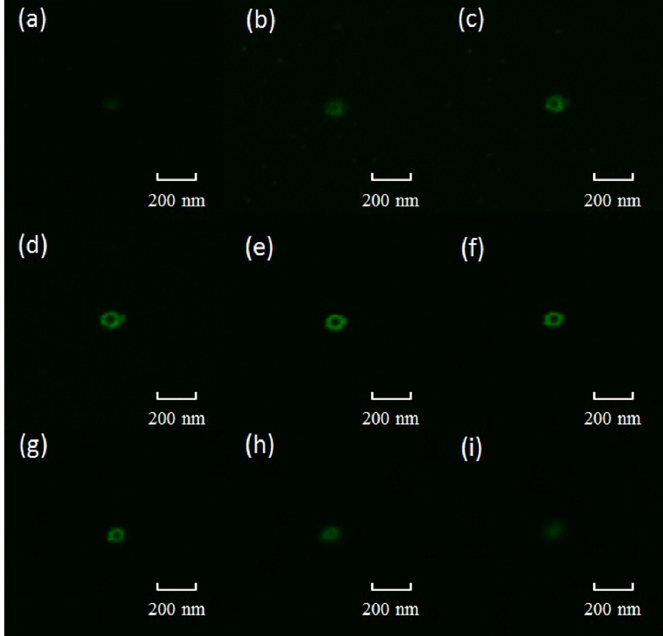
Figure 3. Layer ‐ by ‐ layer confocal laser scanning microscopic (CLSM) photographs of the fluorescein isothiocyanate (FITC) ‐ labeled immobilized enzyme at different scanning depths along the z ‐ axis position ( a – i ). The fluorescence of FITC was monitored at excitation and emission wavelengths of 488 and 530 nm, respectively.